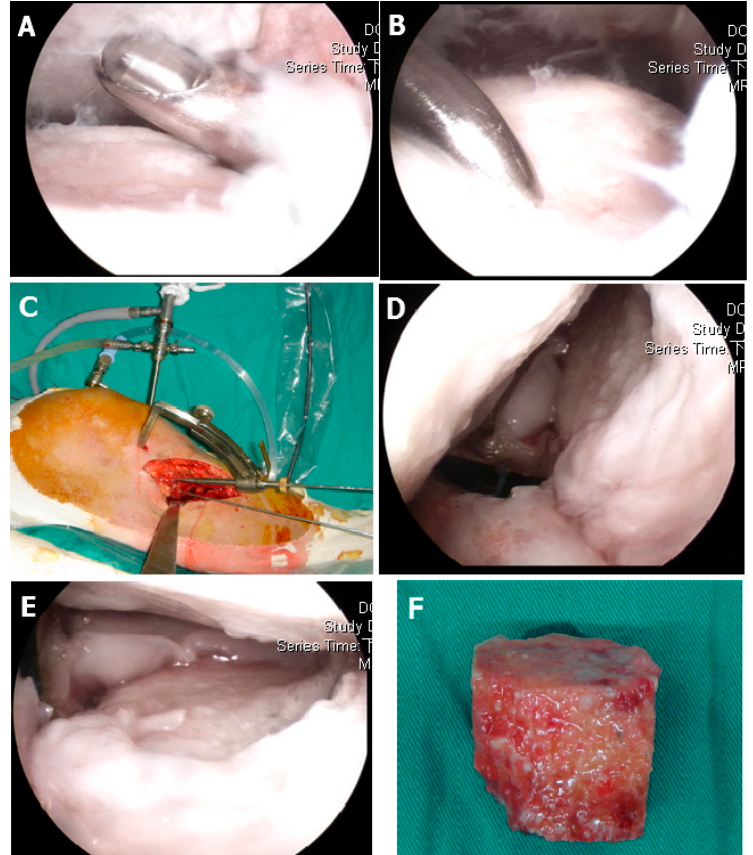
Figure 1. Operative procedure: ( A ) Arthroscopic documentation and debridement. ( B ) Use of a microfracture awl to identify the intra-articular depression zone. ( C ) Anterior cruciate ligament (ACL) tibial guiding for osteotomy axis and location, where two parallel Kirschner wire determined one plane, the 5 mm osteotome started from the metaphysic area to the articular surface. ( D ) The malunited fracture area was completely released. ( E ) The depressed articular fragments were elevated with bone tamp under direct arthroscopically inspection. ( F ) Bone grafting of the metaphyseal defect with structural allograft femoral head.